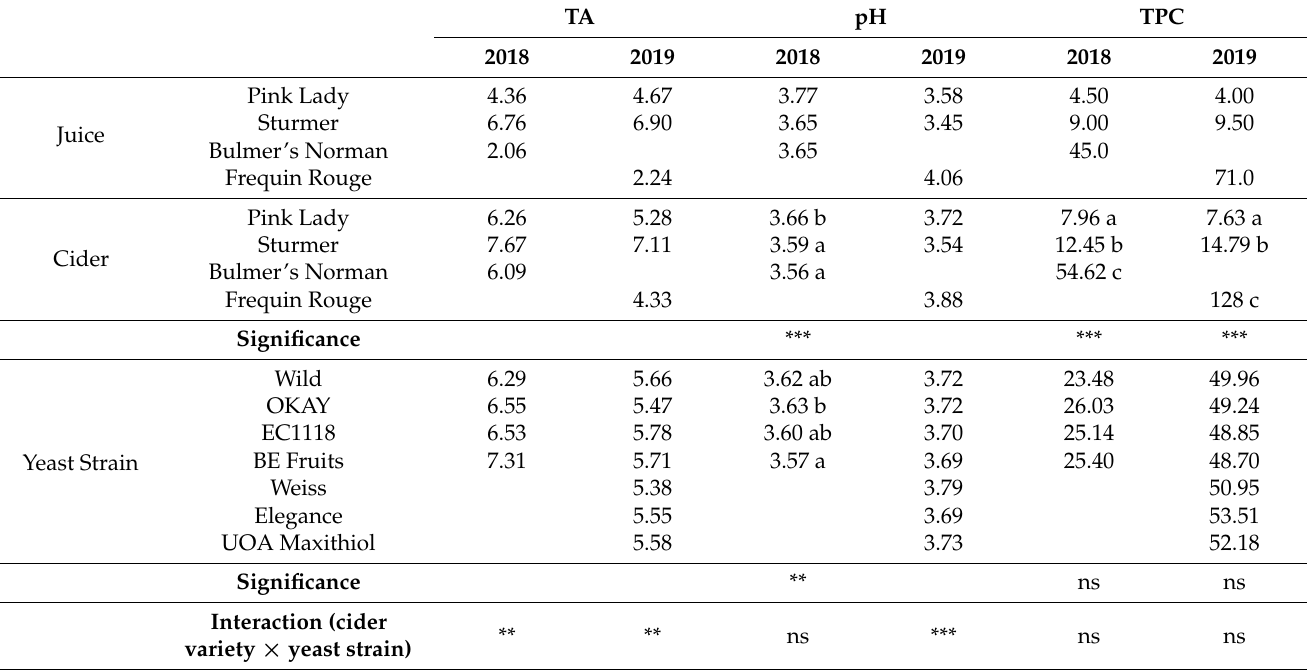
Table 2. Mean TA (malic acid mg/mL), pH, and TPC (TPI) of initial juice (N = 1) samples and ciders for each variety as well as ciders fermented using different yeast strains (average of all three apple varieties) in 2018 and 2019. Cider results represent the average of all yeast strains combined. (* represents p ≤ 0.05, ** is p < 0.01, and *** p < 0.001. Different letters denote significant differences between means at p ≤ 0.05. No significant difference is denoted by